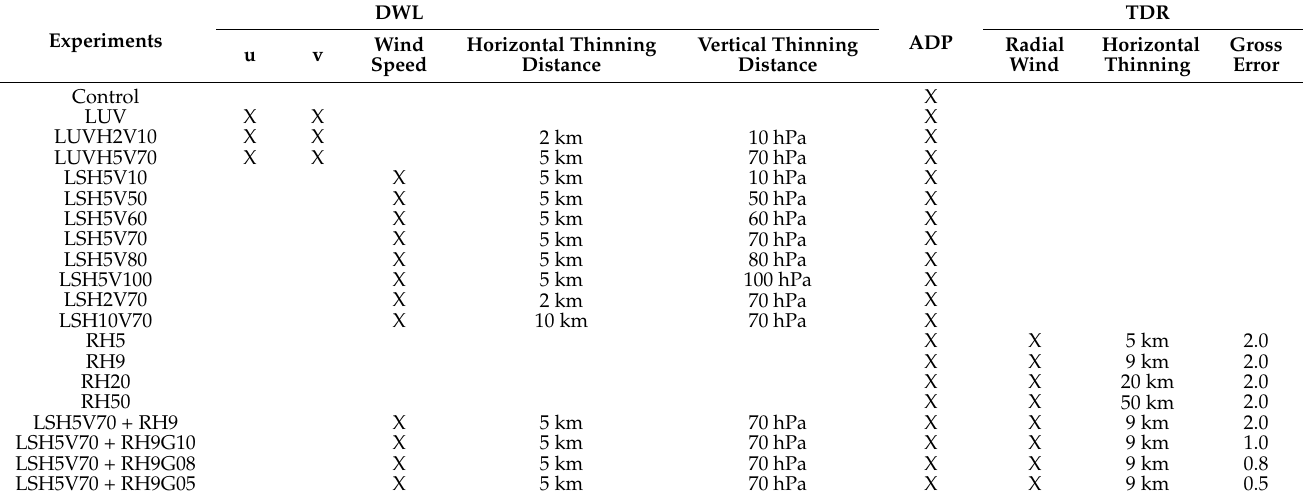
Table 1. Configurations for all assimilation experiments. “ADP” represents ADP conventional data. DWL observed wind speed u and v components is represented by “u” and “v” in the table. The data assimilated in the experiment is marked with “X” in the